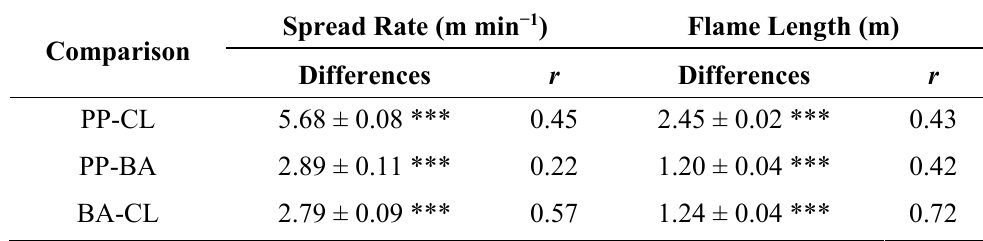
Table 5. Daytime (8 a.m.–6 p.m.) simulations of fire behavior variables during the sequence of high fire danger days: differences (mean ± std. error) and correlations ( r ) within pairs of forest stands, with the significance of the Wilcoxon signed-rank test; n = 110.